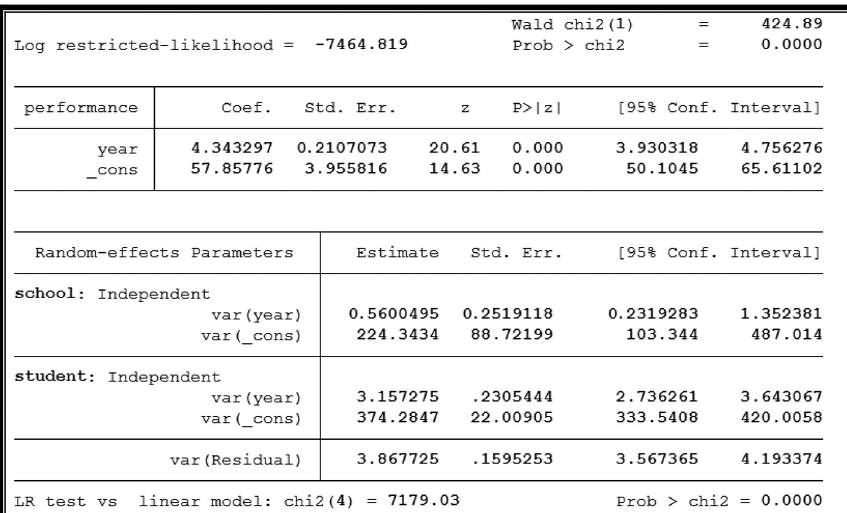
Figure 9. Linear trend model with random intercepts and